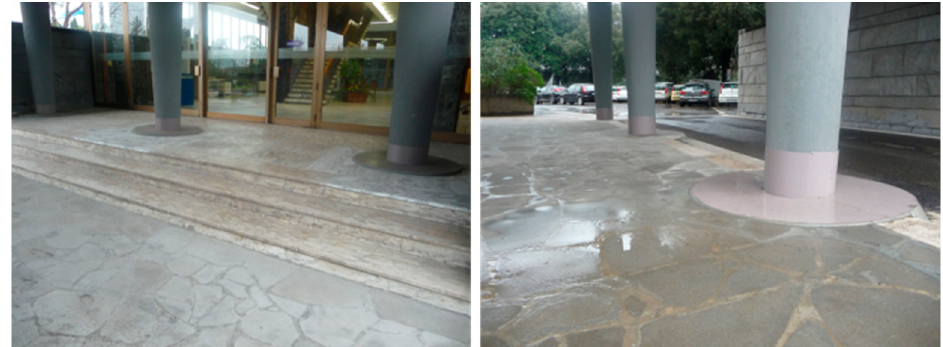
Figure 12. Visual impact of the intervention at the end of the work.